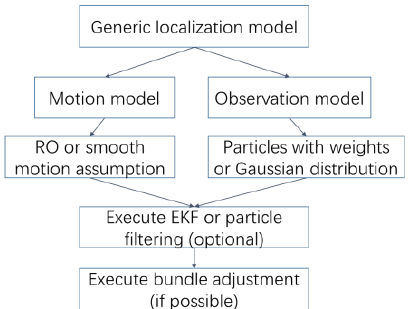
Figure 3. The hierarchical strategy for solving the generic localization model